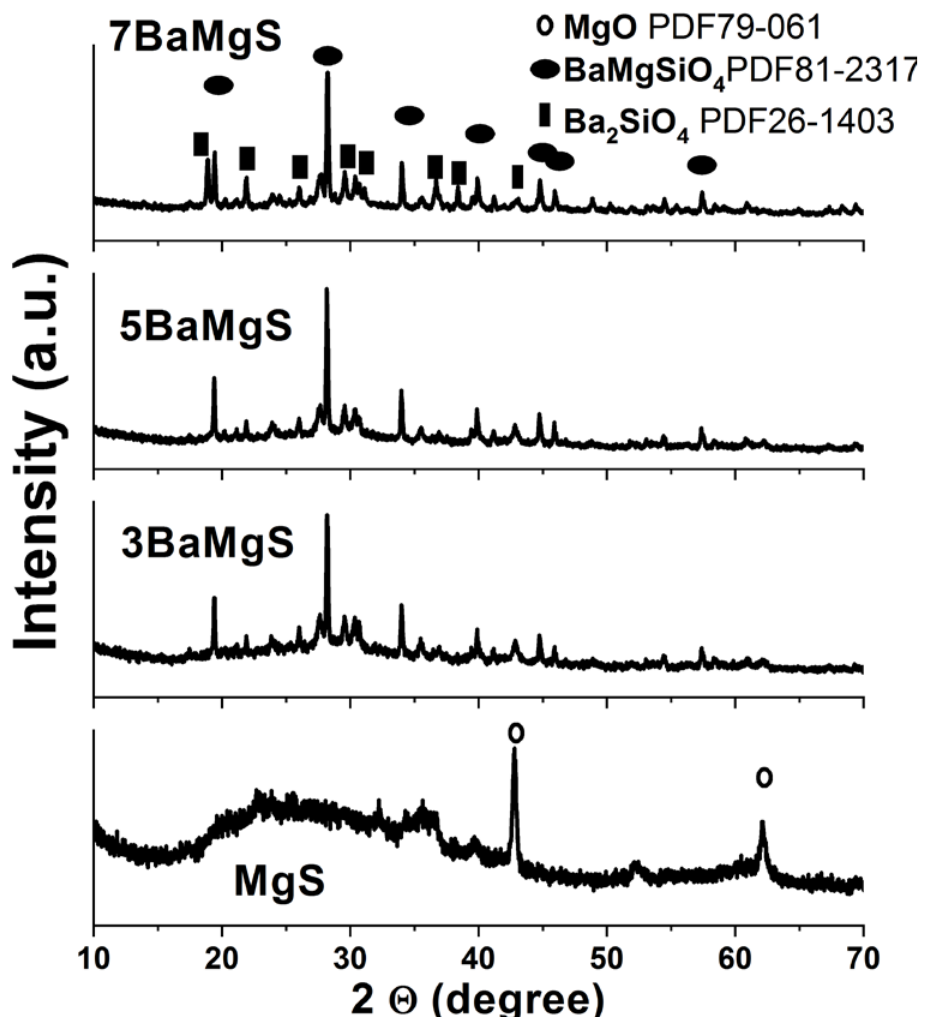
Figure 2. XRD curves of the prepared MgS samples before and after doping with barium.